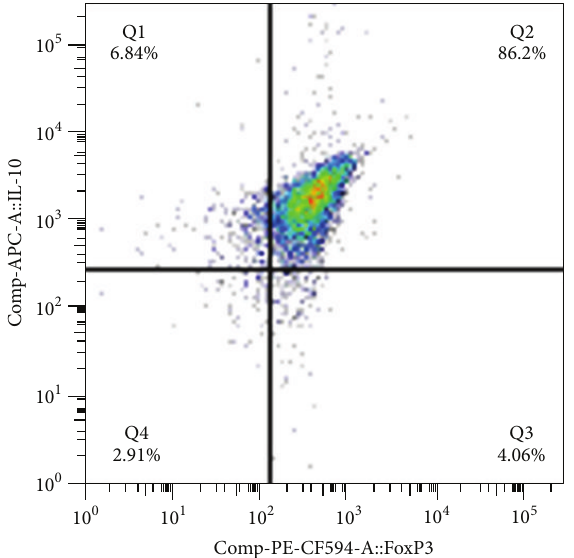
Figure 2: A demonstrative FACS analysis of purified B cells, showing that activated CD 19 + CD 25 high FoxP 3 high are also IL- 10 high . Of note is that CD 25 dim-low \ FoxP 3 dim-low B cells express very little